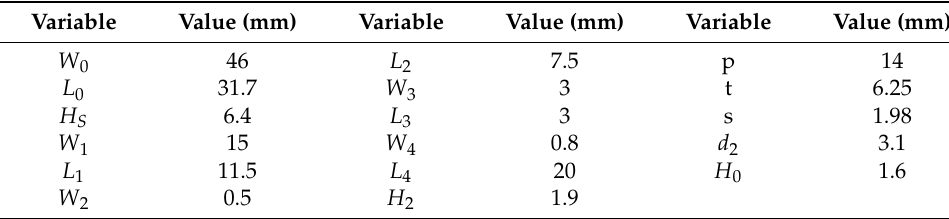
Table 1. Values of the antenna variables.